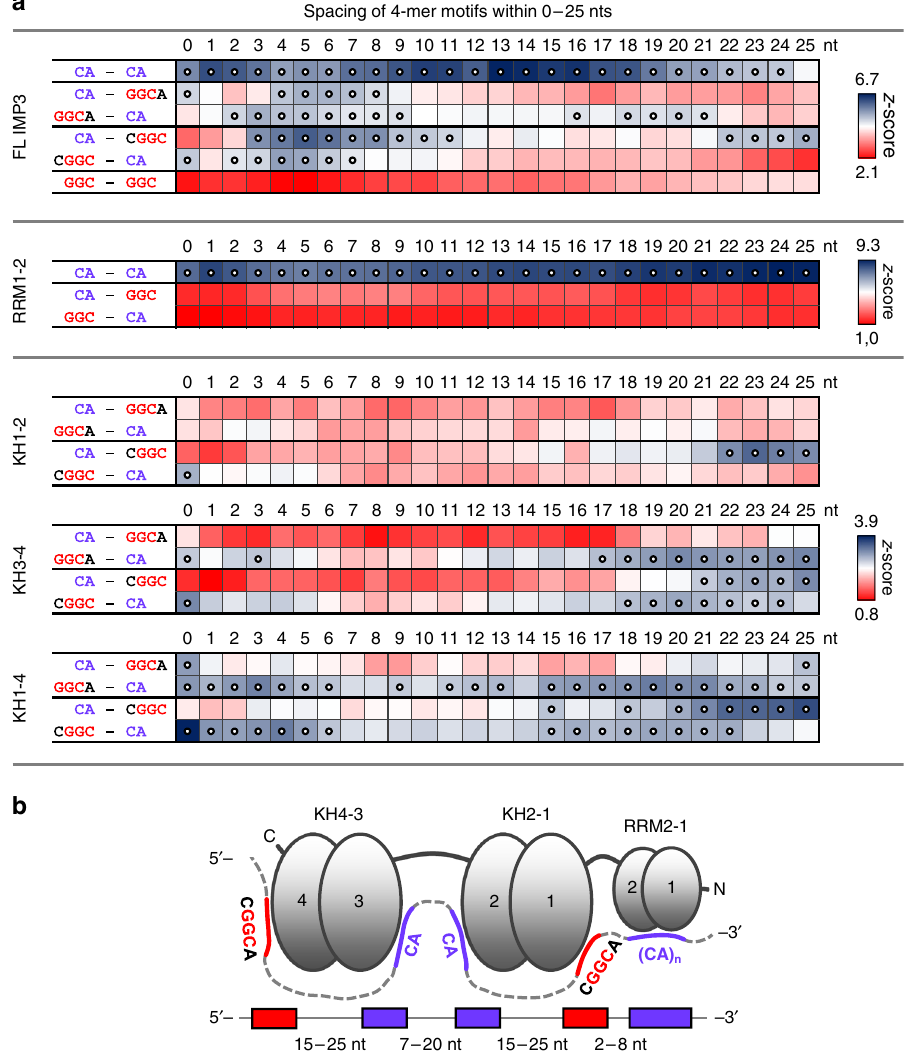
Fig. 2 Spacing analysis reveals a consensus array of IMP3-binding motifs. a Enrichment of motif combinations with spacing between 0 and 25 nts for the full-length IMP3 (top), and RRM1 – 2 (middle), KH1 – 2, KH3 – 4, and KH1 – 4 domains (bottom), measured by a z -score and shown as a heat map. The combinations of the two GGC-core elements (GGCA/CGGC) with CA-rich motifs are shown for full-length IMP3 and the KH-containing derivatives, the combinations of two GGC-core elements (GGC/GGC) for full-length IMP3 only. Spacing between CA-rich motifs was analyzed for full-length IMP3 as well as RRM1 – 2 (for a summary of all combinations of CA-rich and GGC-core motifs, see Supplementary Data 2 and Methods). Individual z -score scales are given on the right. Positions with z-scores above the threshold used for description are indicated by circles (FL-IMP3 and RRM1 – 2: z -score >4.6; KH1 – 2, KH3 – 4, and KH1 – 4: z -score >2.5). b Model for RNA recognition by IMP3, based on SELEX-seq